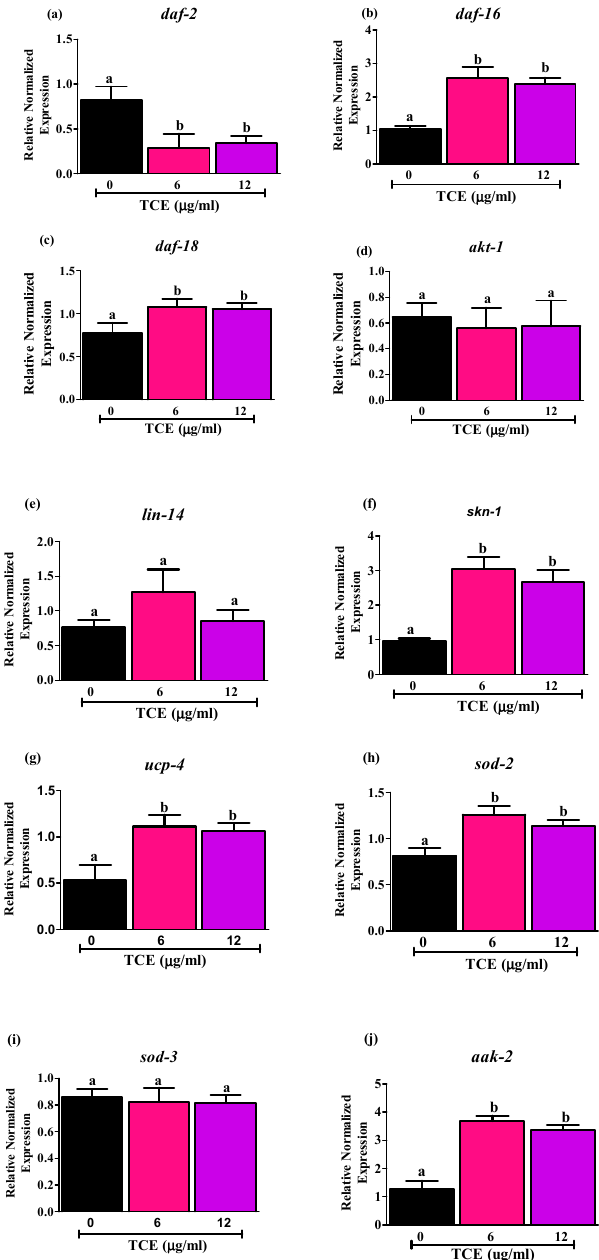
Figure 2. E ff ects of tart cherry extracts (TCE) on mRNA levels of ( a ) daf-2 , ( b ) daf-16 , ( c ) daf-18 , ( d ) akt-1 , ( e ) lin-14 , ( f ) skn-1 , ( g ) ucp-4 , ( h ) sod-2 , ( i ) sod-3 , and ( j ) aak-2 . mRNA expression of daf-2 , daf-16 , daf-18 , skn-1 , ucp-4 , sod-2 , aak-2 was significantly di ff erent with 6 and 12 µ g / mL TCE worms compared to not treated (0 µ g / mL) worms (di ff erent letters (a, b) are significantly di ff erent, p < 0.05, One-way ANOVA, n = 5, five independent experiments with triplicates). There is no significant di ff erence in the mRNA levels of akt , lin-14 and sod-3 in the 6 and 12 µ g / mL treated worms compared to not treated worms (0 µ g / mL). Synchronized worms (approx. n ~ 1000) grown in the axenic media were treated with 0, 6, and 12 µ g / mL TCE, and gene expression analysis was performed at day 10 after 3 days of treatment.